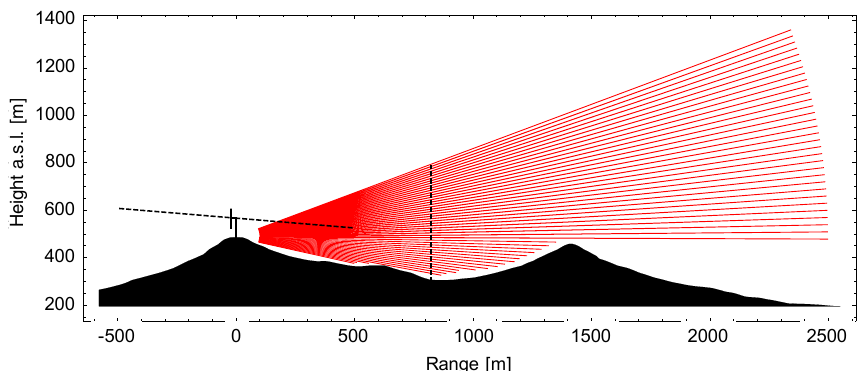
Figure 10. Transect scan: red lines indicate LOS measurements acquired by LR3, the vertical dashed line shows the position of the virtual mast, and the inclined horizontal dashed line indicates the position of the diamond scan